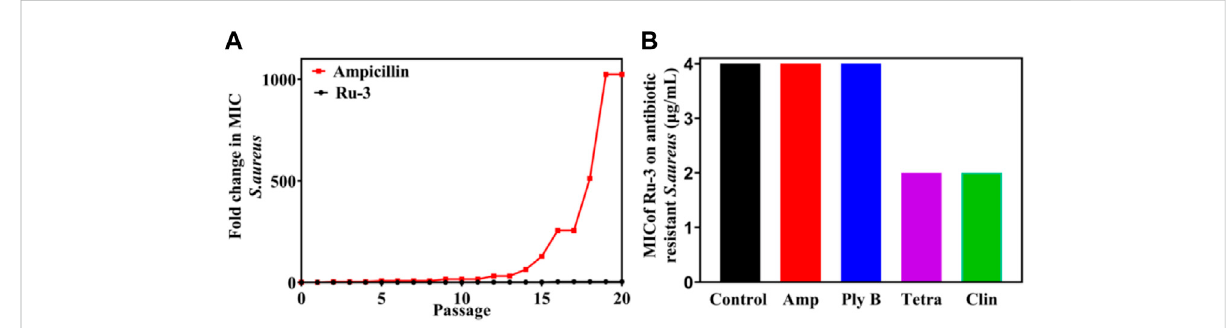
FIGURE 7 Bacterial resistance study of compound Ru-3 against S. aureus (Ampicillin was selected as a reference drug). (A) Fold changes in MIC values of compoundRu-3andampicillinagainst Staphylococcusaureus . (B) MICofRu-3ondifferentantibioticresistant Staphylococcusaureus .Control:Wild Staphylococcus aureus . Amp: Ampicillin resistant Staphylococcus aureus . Ply (B) Polymyxin B resistant Staphylococcus aureus . Tetra: tetracycline resistant Staphylococcus aureus . Clin: Clindamycin resistant Staphylococcus aureus